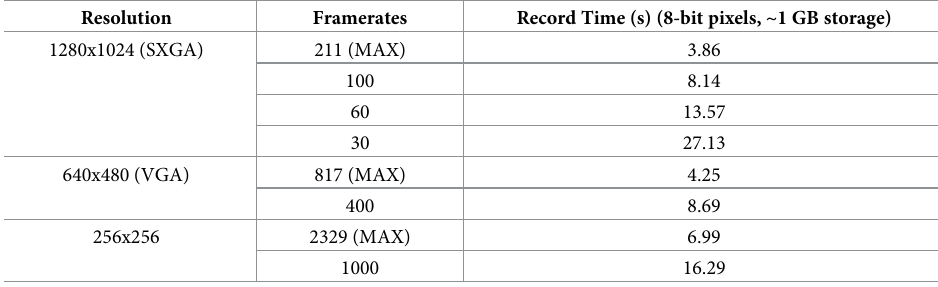
Table 1. List of 8 camera configurations supported by 3 PMOD